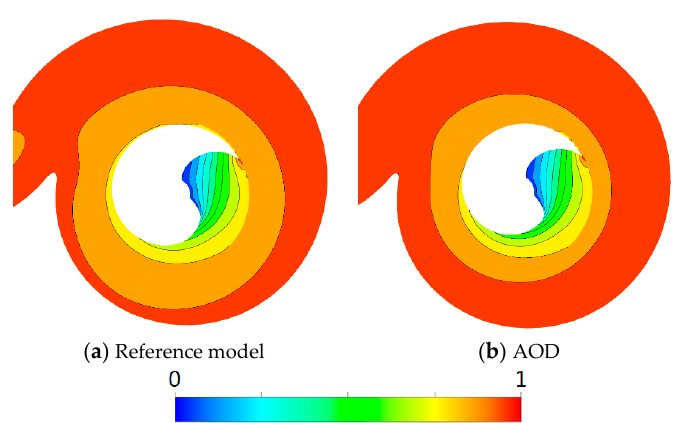
Figure 14. Time-averaged pressure contours at mid-span.